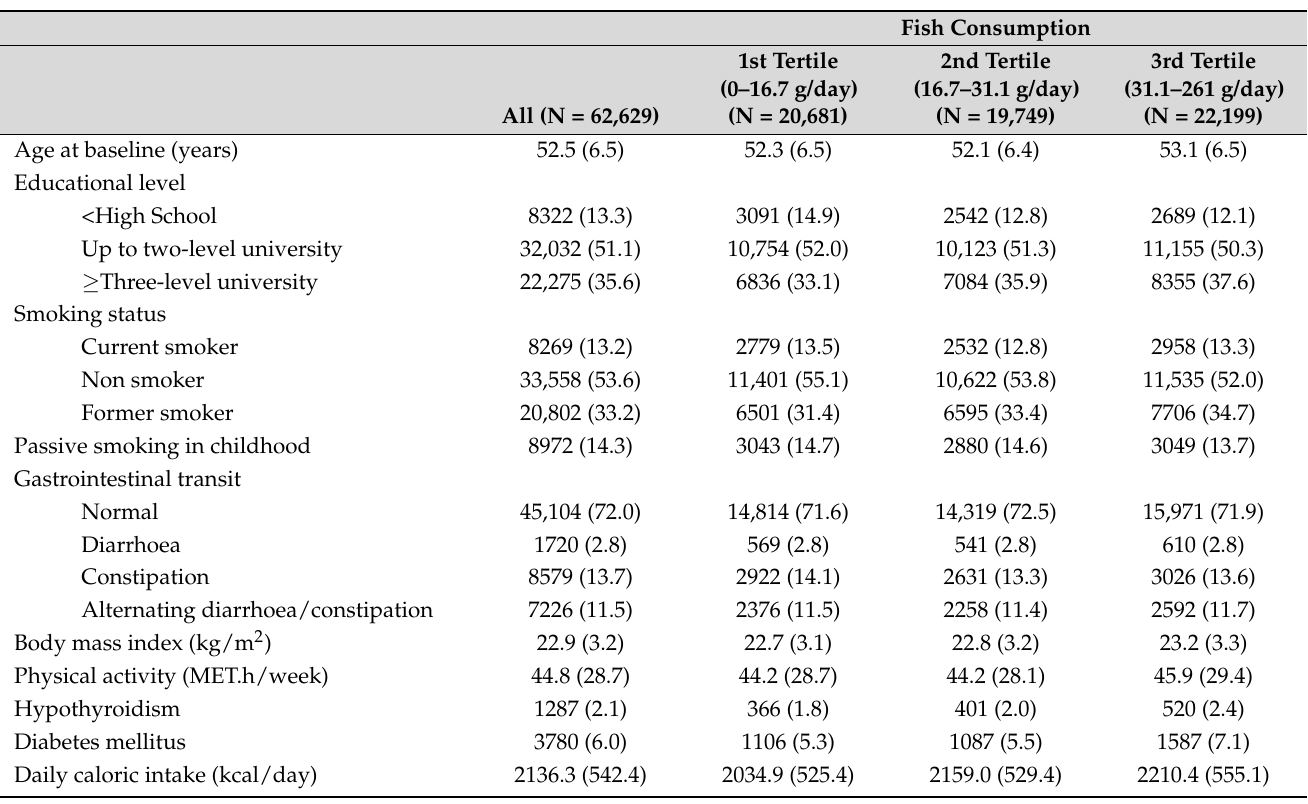
Table 1. Characteristics of the study population at baseline by tertiles of fish consumption (N = Figure 1. Flow chart of the study. RA: rheumatoid arthritis; IRD: inflammatory rheumatic disease;